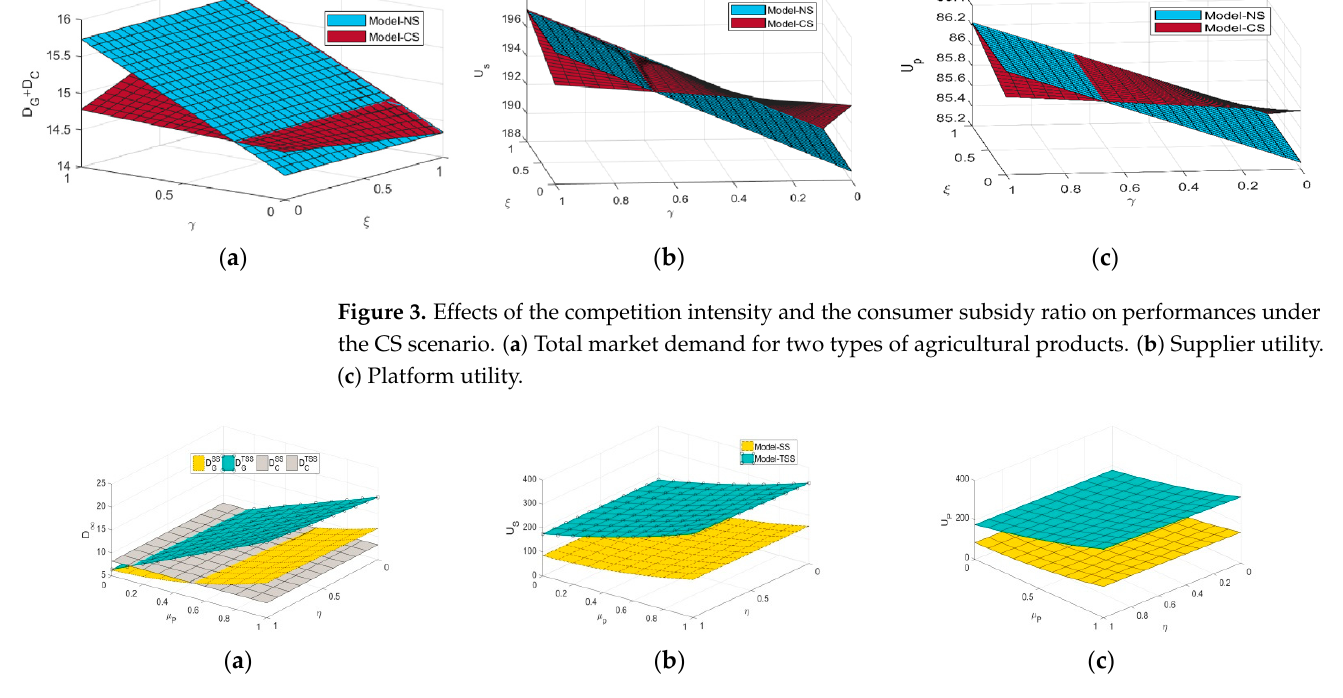
Figure 4. Impacts of green traceability factors η and u P on performances in the SS and TSS scenarios. ( a ) Market demand for two types of agricultural products. ( b ) Supplier utility. ( c ) Platform utility.